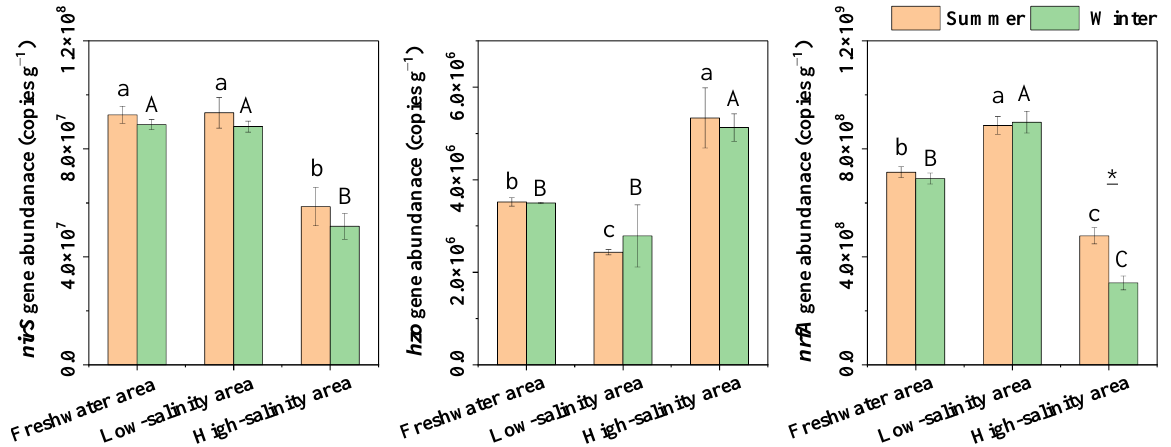
Figure 2. The functional gene abundance in the freshwater, low-salinity and high-salinity area. Different lowercase and uppercase letters indicate significant spatial differences ( p < 0.05), and the asterisks denote significant seasonal differences ( p < 0.05).